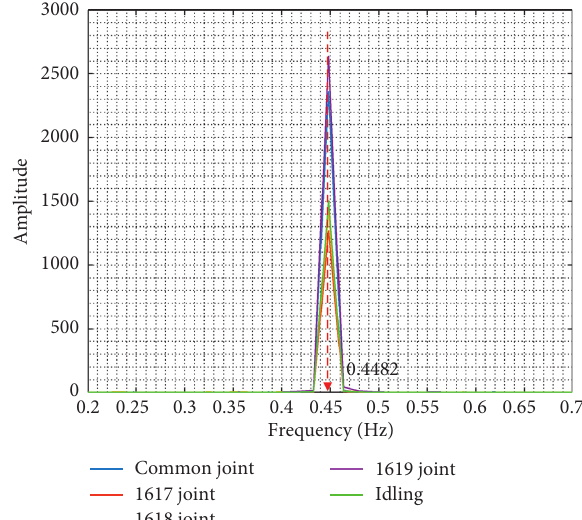
Figure 6: Amplitude spectrum of torque with a rotation speed of 30 r/min and a penetration rate of